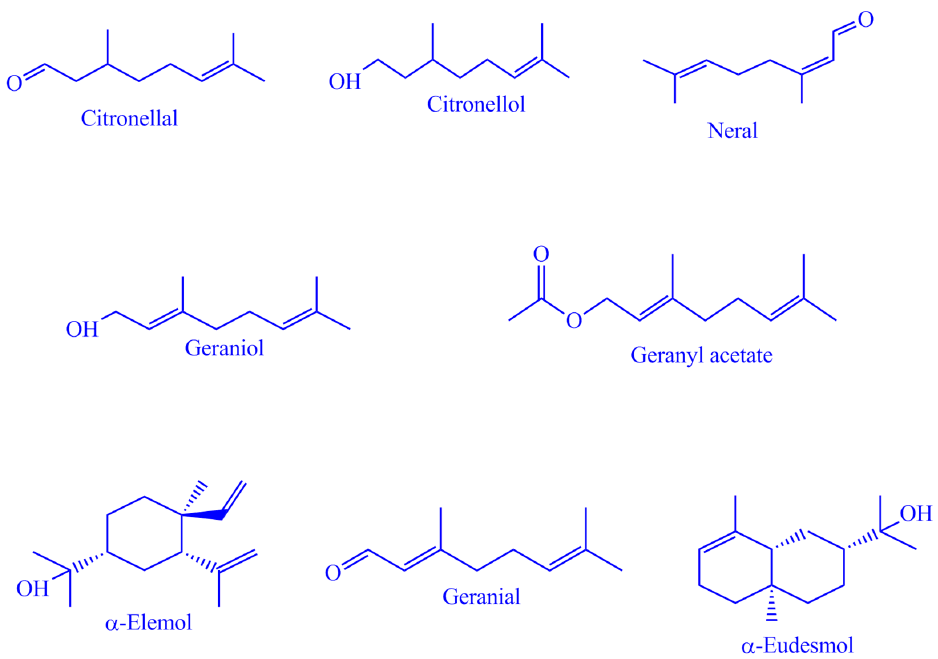
Figure 1. Major compounds present in different cymbopogon species.